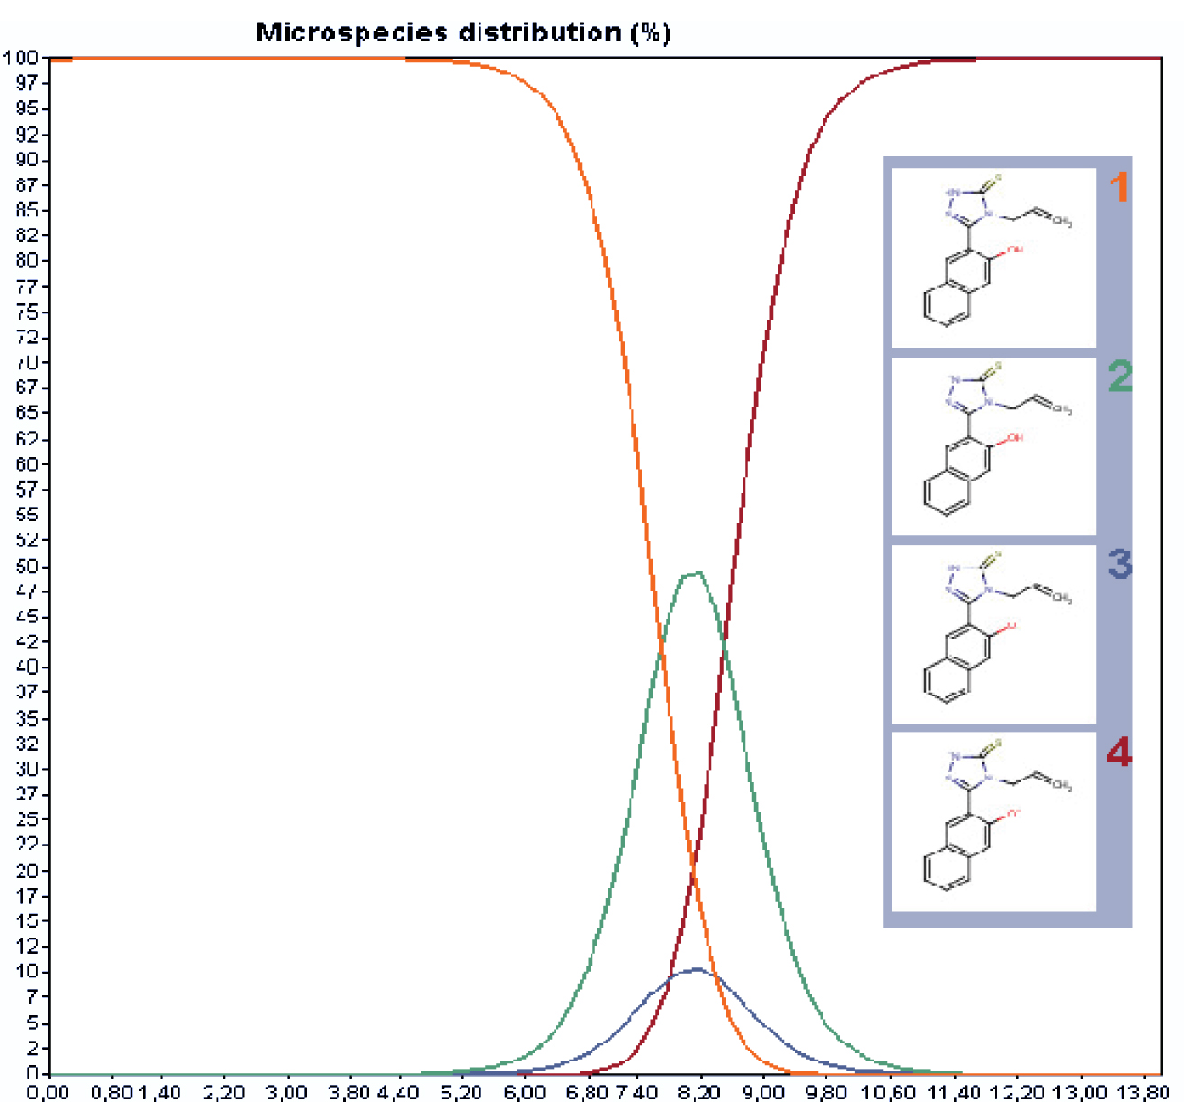
Figure 4. Species repartition of compound 1 in solution at different